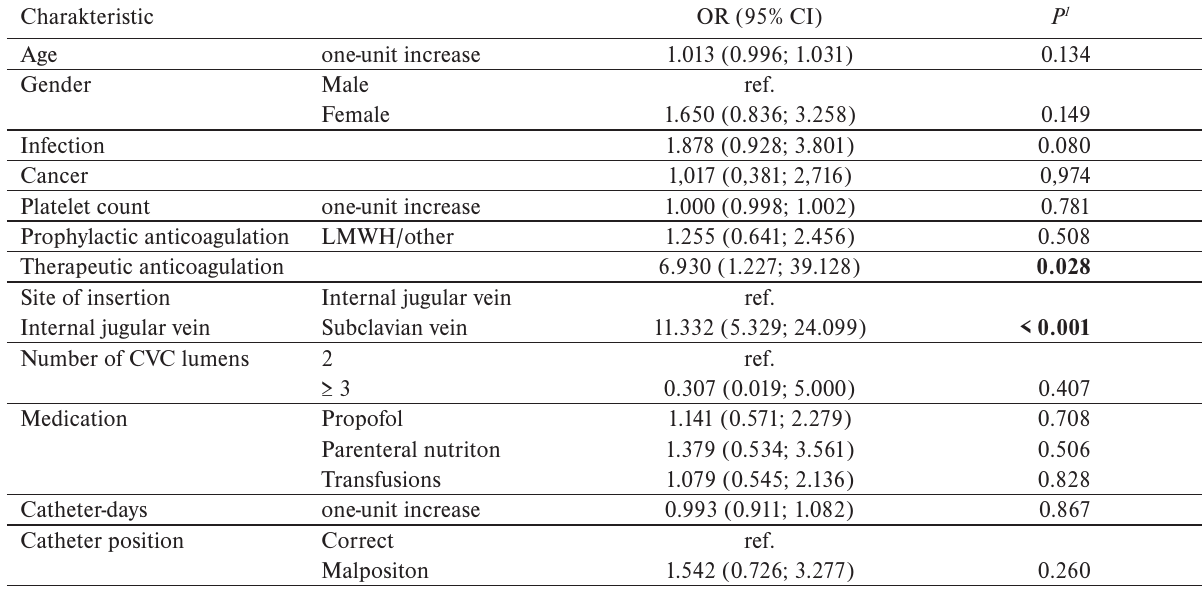
Table 6. Risk factors for catheter related deep vein thrombosis.